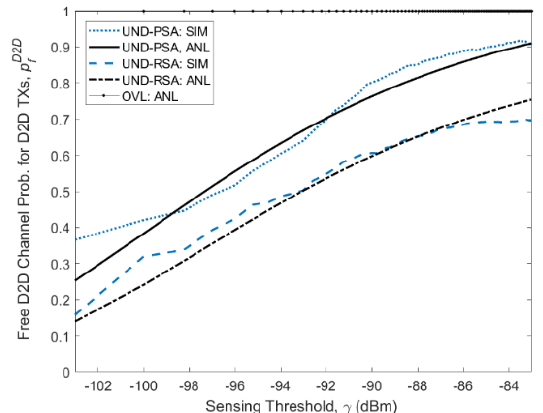
Figure 6. The probability that the D2D channel 𝑐 𝑑 is free inside the D2D protection region (i.e., 𝑝 𝑓D2D ) as a function of the spectrum sensing threshold 𝛾 (in dBm).